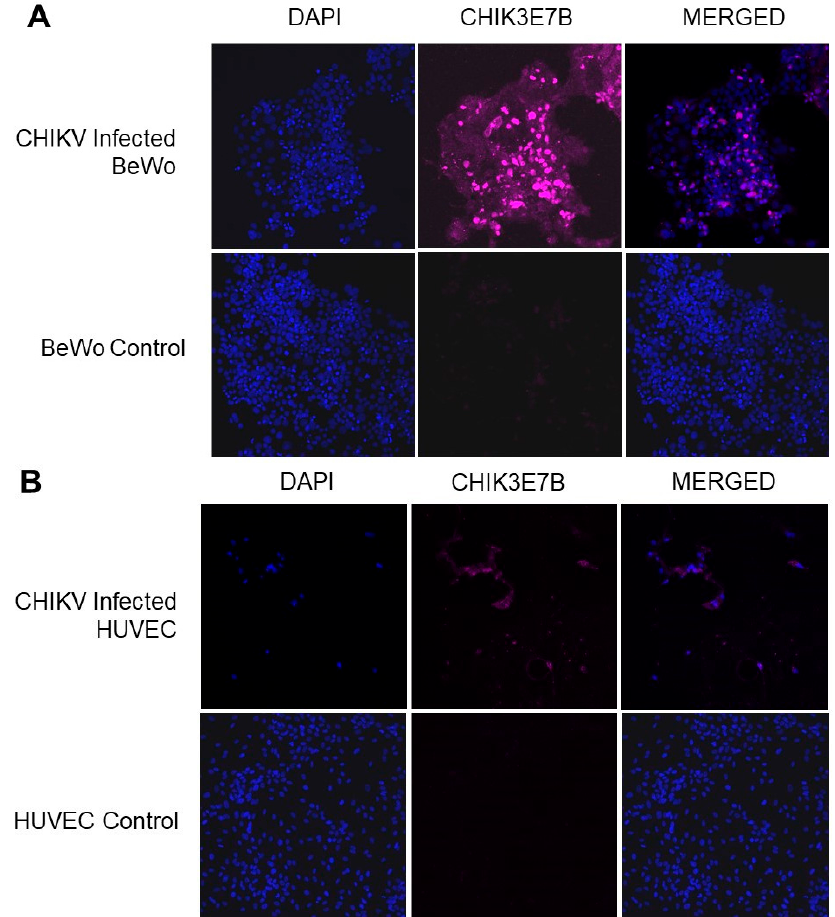
e ff ects (CPE) At 72 h post infection (p.i.), HUVEC cells showed increased CPE consisting of cell rounding and sloughing, whereas BeWo cells showed no CPE.